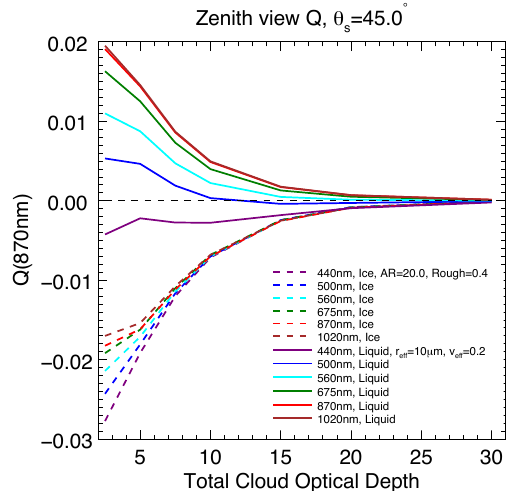
Figure 5. Simulated Q as a function of scattering angle (defined as the angle from the solar incidence direction) for a liquid cloud (blue), ice cloud with an extreme aspect ratio (green), and an ice cloud with a more compact aspect ratio (red). The line style indi- cates the simulation solar zenith angle.